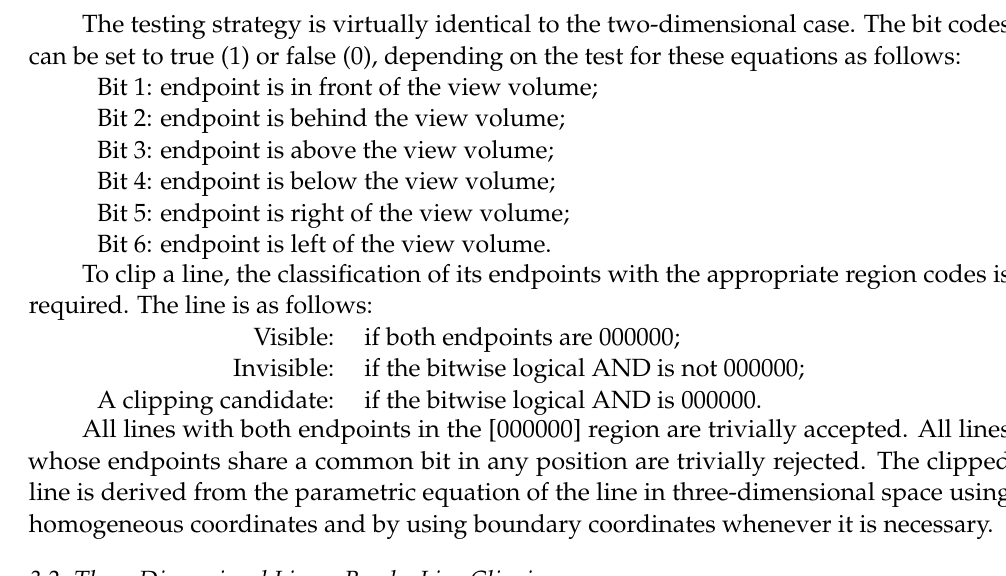
Figure 11. Three-dimensional six-bit region